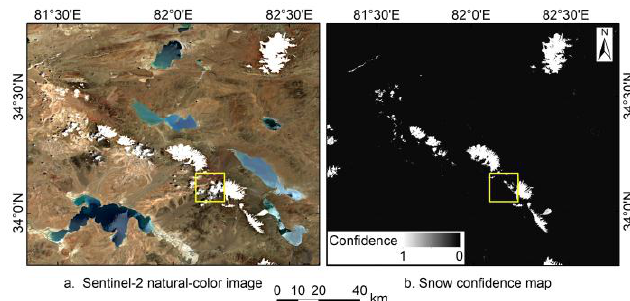
Figure 3. Natural-color image and the snow confidence map of